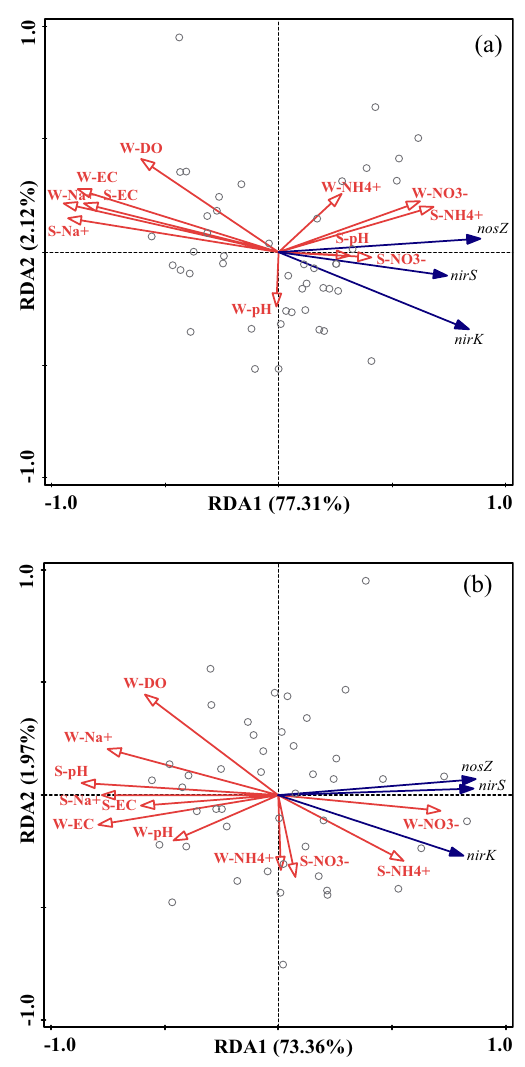
Figure 4. Redundancy analysis (RDA) plot of the relationship between the abundances of denitrifying functional genes and environmental factors ( a , saline environment; b , saline-alkali environment). Solid blue lines indicate the denitrifying gene abundances, and solid red lines show environmental factors. “W-” and “S-” indicate the overlying water and sediment,